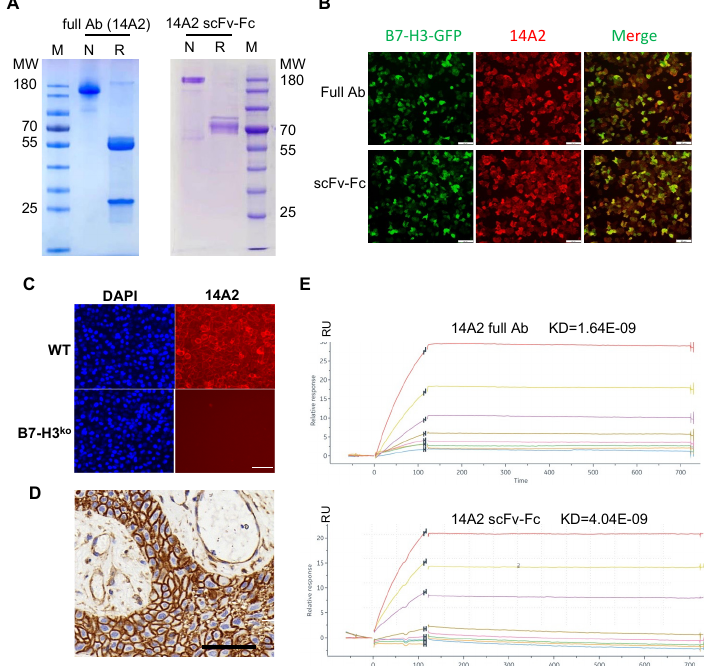
Figure 2. Validation and characterization of B7-H3-targeting monoclonal antibody and scFv. ( A ) SDS- PAGE analysis of purified antibody clone 14A2 and the derived scFv-Fc. ( B ) Immunofluorescence staining of 14A2 full antibody and scFv binding to Hela cells with B7-H3-EGFP stably expressing, scale bar: 100 µ m. ( C ) Wild and B7-H3KO DU145 cells were used to verify the binding specificity of 14A2 by IF staining, scale bar: 100 µ m. ( D ) Immunohistochemical staining analysis of CP clinical tumor samples with 14A2 antibody, scale bar: 50 µ m. ( E ) Affinity analysis of 14A2 antibody and the derived scFv-Fc fragment to recombinant extracellular domain protein of B7-H3. R, reducing; N, non-reducing; M, marker.